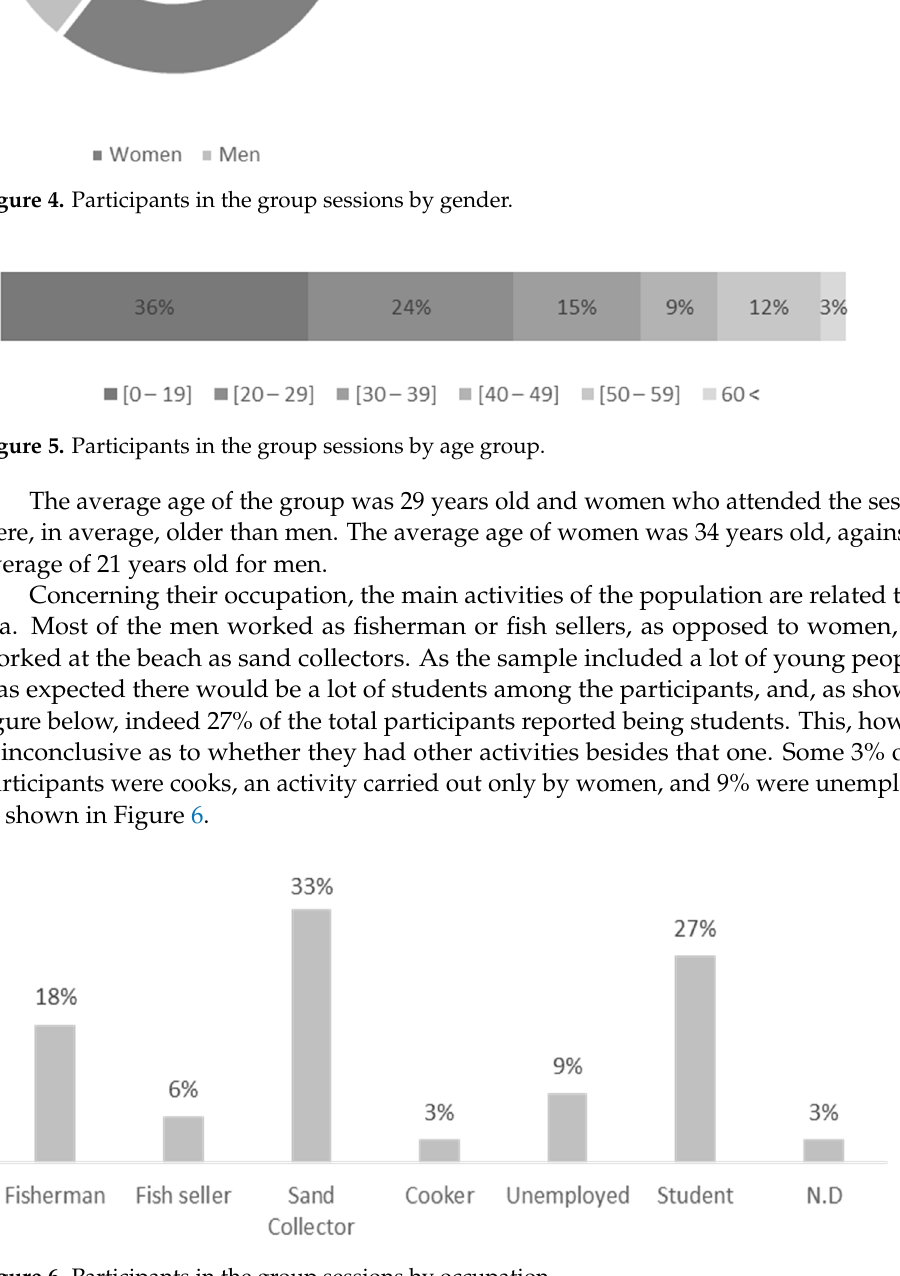
Figure 6. Participants in the group sessions by occupation.